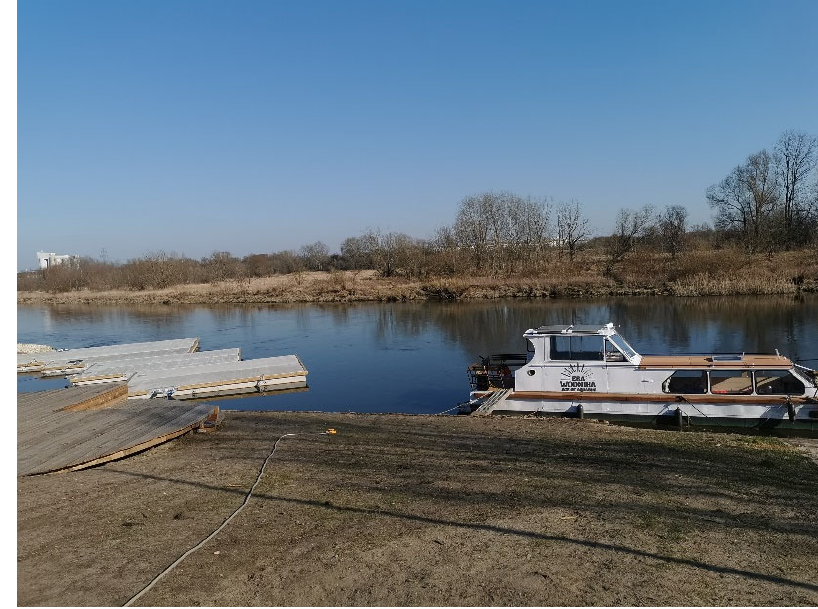
Figure 5. Marina for river boats (Roman Andrzejak 2022).